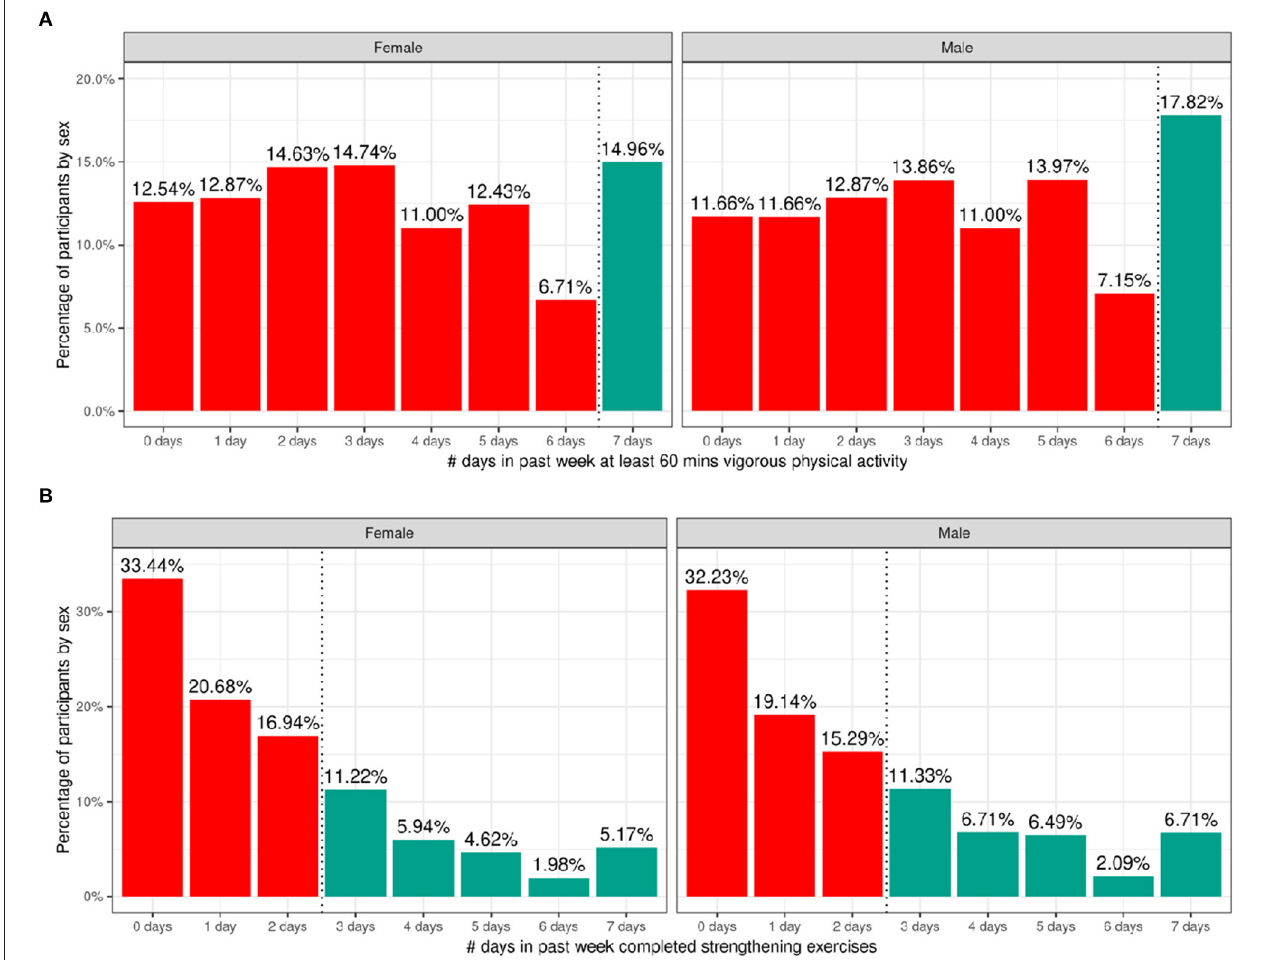
FIGURE 7 | Distribution of time spent participating in physical activity across the ABCD sample. (A) Distribution of number of days in the past week participants (stratified by sex assigned at birth) spent participating in at least 60min of vigorous physical activity. (B) Distribution of number of days in the past week participants (stratified by sex assigned at birth) completed strengthening exercises. Participants that met CDC guidelines for recommended duration of physical activity (green) and that did not meet guidelines